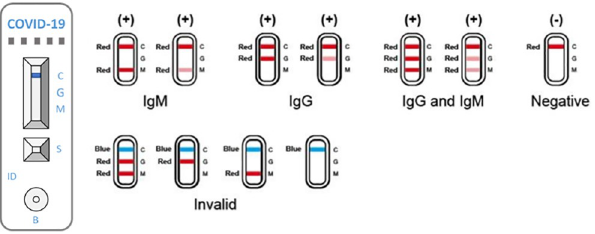
Fig 1. Interpretation of results for COVID-PRESTO 1 . COVID-PRESTO 1 uses anti-human immunoglobulin (Ig) M antibody (test line M), anti-human IgG antibody (test line G) and rabbit IgG (control line C) immobilized on a nitrocellulose strip. The Conjugate (recombinant COVID-19 antigens labeled with colloidal gold) is also integrated into the strip. A specimen is added to the sample well (S) followed by addition of assay buffer to the buffer well (B), IgM and/or IgG antibodies if present, will bind to COVID-19 conjugates forming antigen-antibody complexes. These complexes migrate through the nitrocellulose membrane by capillary action. When the complex meets the line of the corresponding immobilized antibody (anti-human IgM and/or anti-human IgG), the complex is trapped forming a burgundy colored band which confirms a reactive test result. The absence of a colored band in the test region indicates a non-reactive test result. To serve as a procedural control, a colored line always changes from blue to red in the control line region, indicating that the proper volume of specimen has been added and membrane wicking has occurred. If the control line does not switch colors, then the test is deemed